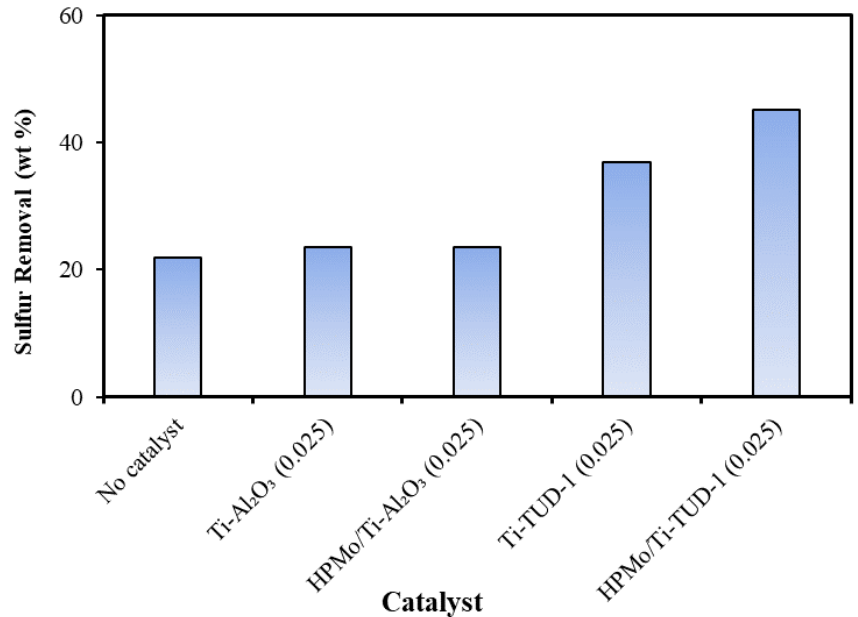
Figure 7. ODS of tire pyrolysis oil over HPMo/Ti-Al 2 O 3 (0.025) and HPMo/Ti-TUD-1(0.025) cata- lyst/feed = 0.05; T = 70 °C; oxidant = 30% H 2 O 2 ; H 2 O 2 /S = 10; t = 2 h; and stirring rate = 550 rpm .